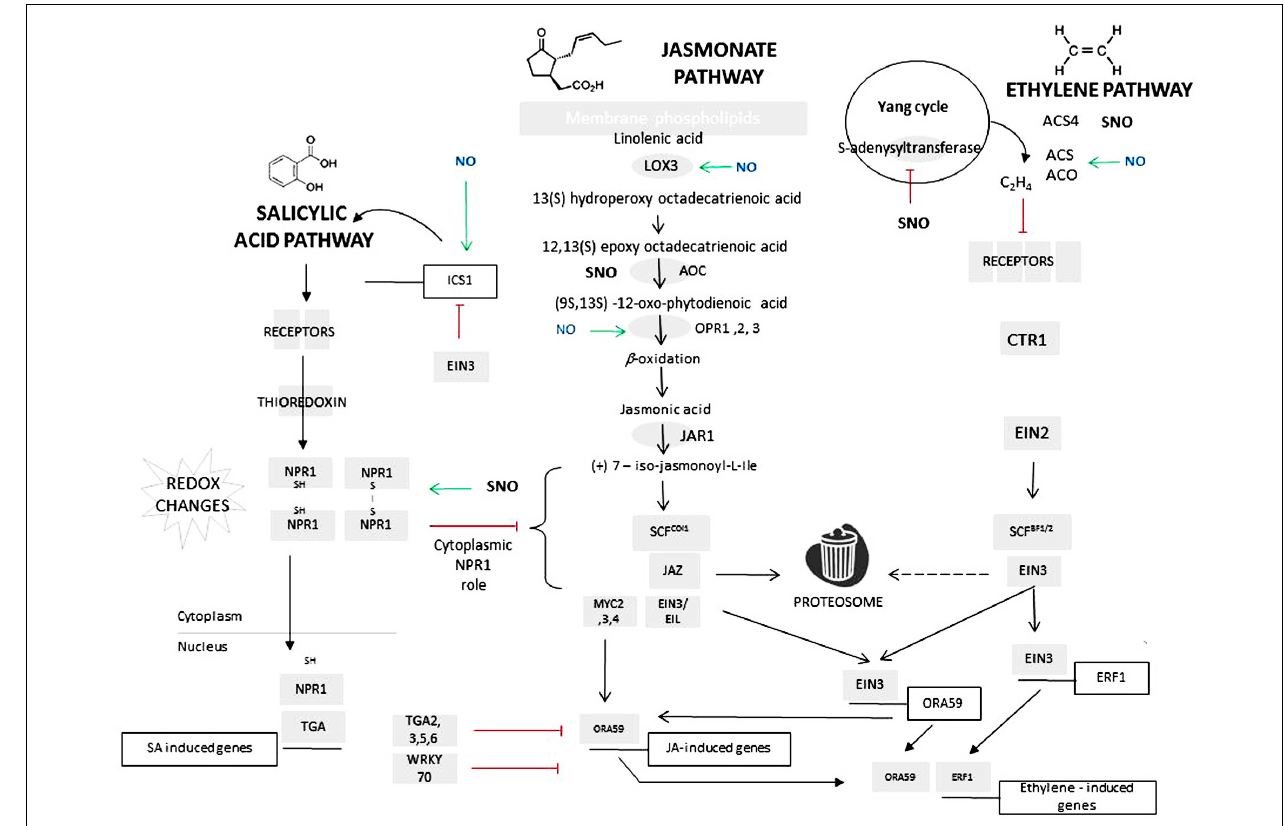
-carboxylic acid oxidase. Genes and their regulatory promoters are represented as open boxes. For details of signaling cascades, see main text.The known NO-regulated steps are indicated: green arrows indicating that NO has a promontory effects via induction of gene transcription; S -nitrosylative steps are indicated via a solid black bar and whether this promotes (green arrows) or inhibit a signaling (red bar) step. Note that for and ACO and ACS4, the effect of S -nitrosylation has yet to be